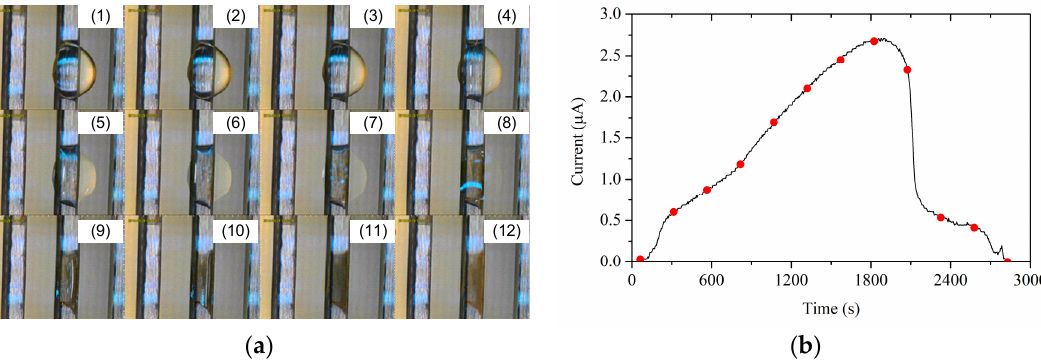
Figure 6. Change of a droplet on a sensor ( a ) and its current curve ( b ).